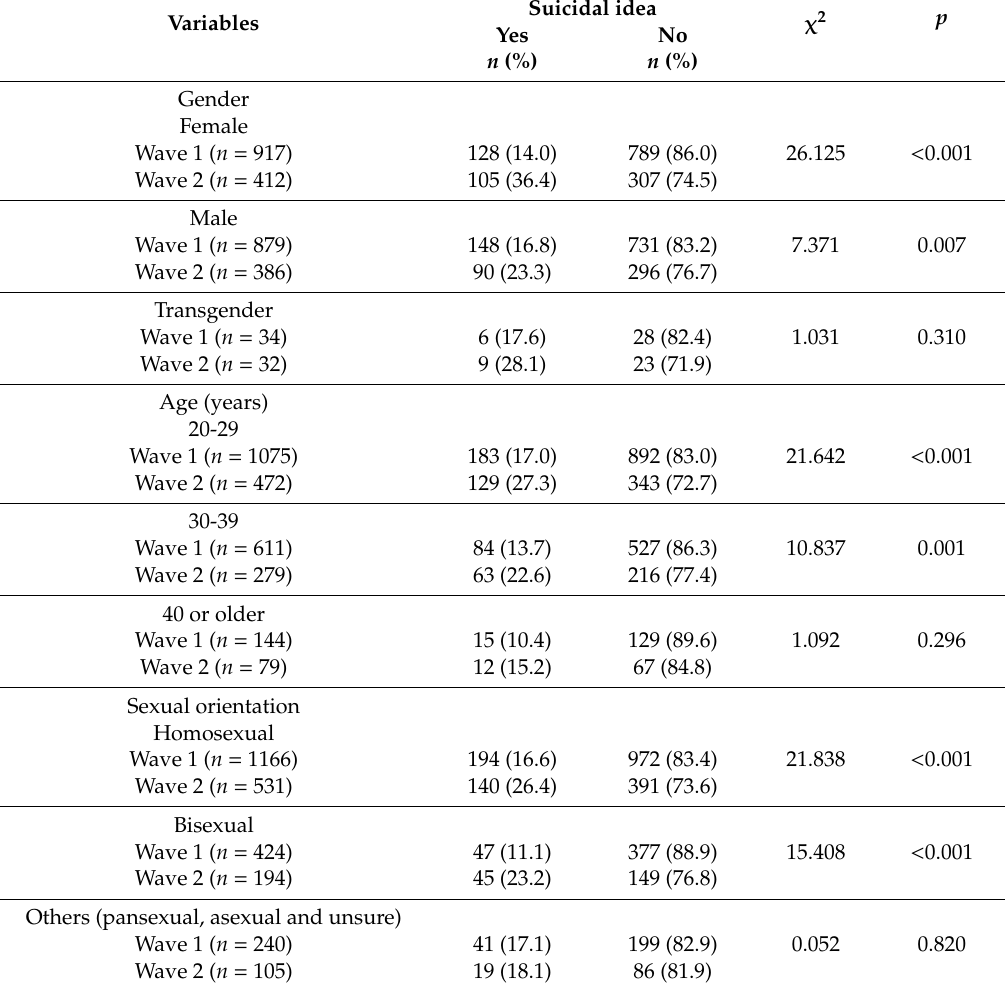
Table 2. Comparison of suicidal ideation rates in nonheterosexual participants between the Wave 1 and Wave 2 surveys: gender, age, and sexual orientation e ff